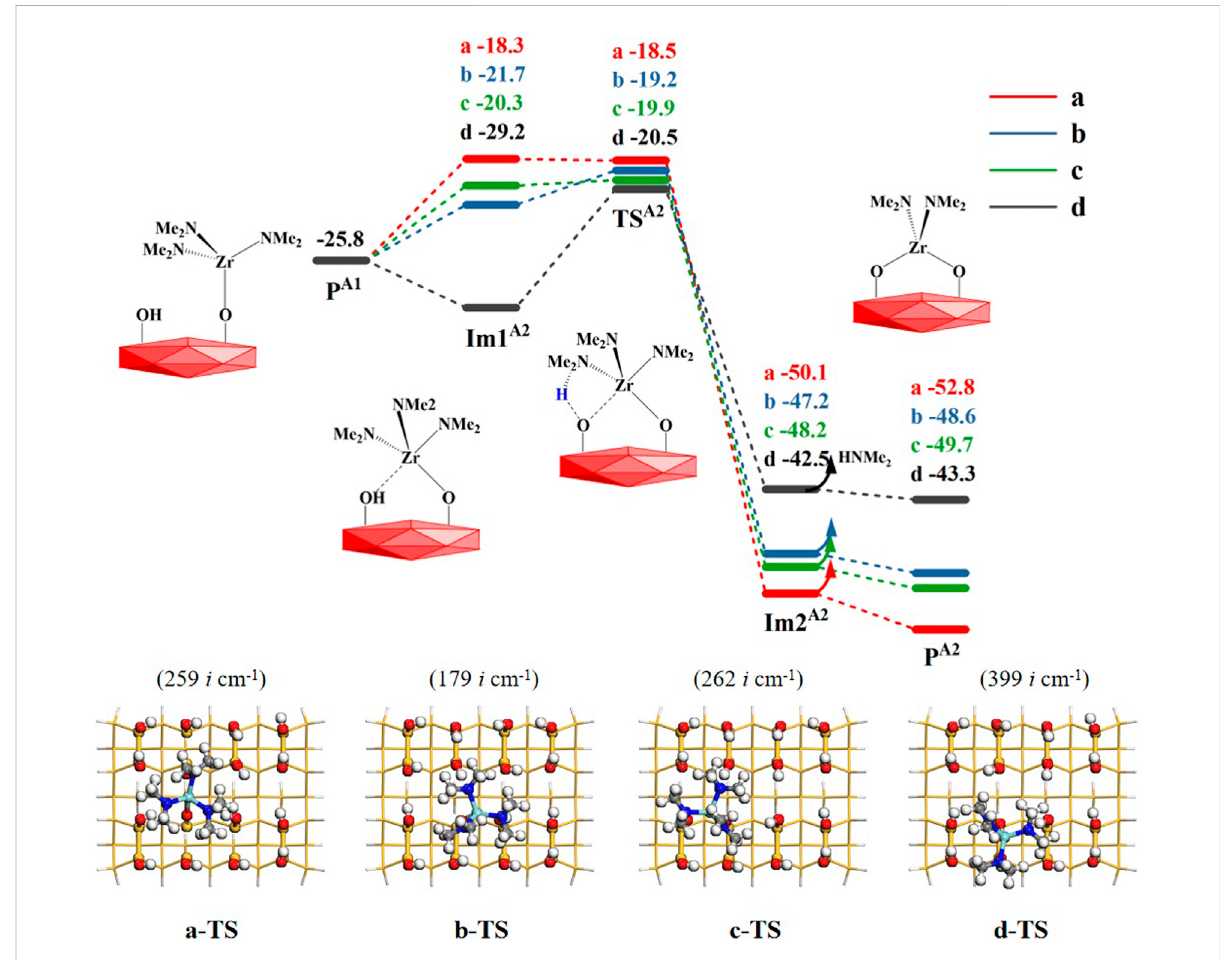
FIGURE 4 Gibbs free energy pro fi les ( Δ G , kcal/mol) of the A2 section of the TDMAZ reaction with the hydroxylated surface at 473.15 K and 0.2 Torr. Symbols a, b, c and d represent four different directions of – OZr(NMe 2 ) 3 with adjacent hydroxyl groups.